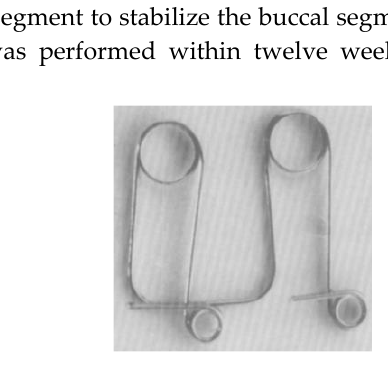
Figure 4: Burstone cuspid retraction spring